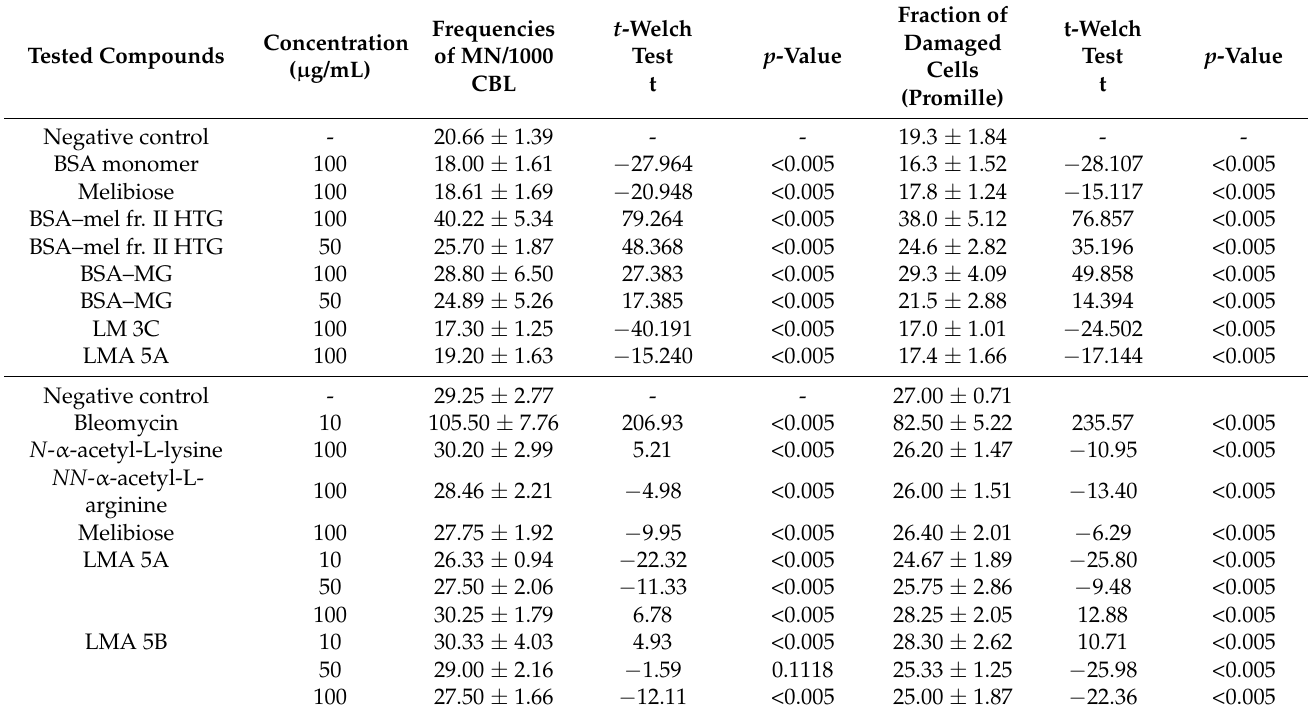
Table 1. Micronuclei analysis results of advanced glycation end-products genotoxicity, obtained in two sets of experiments.